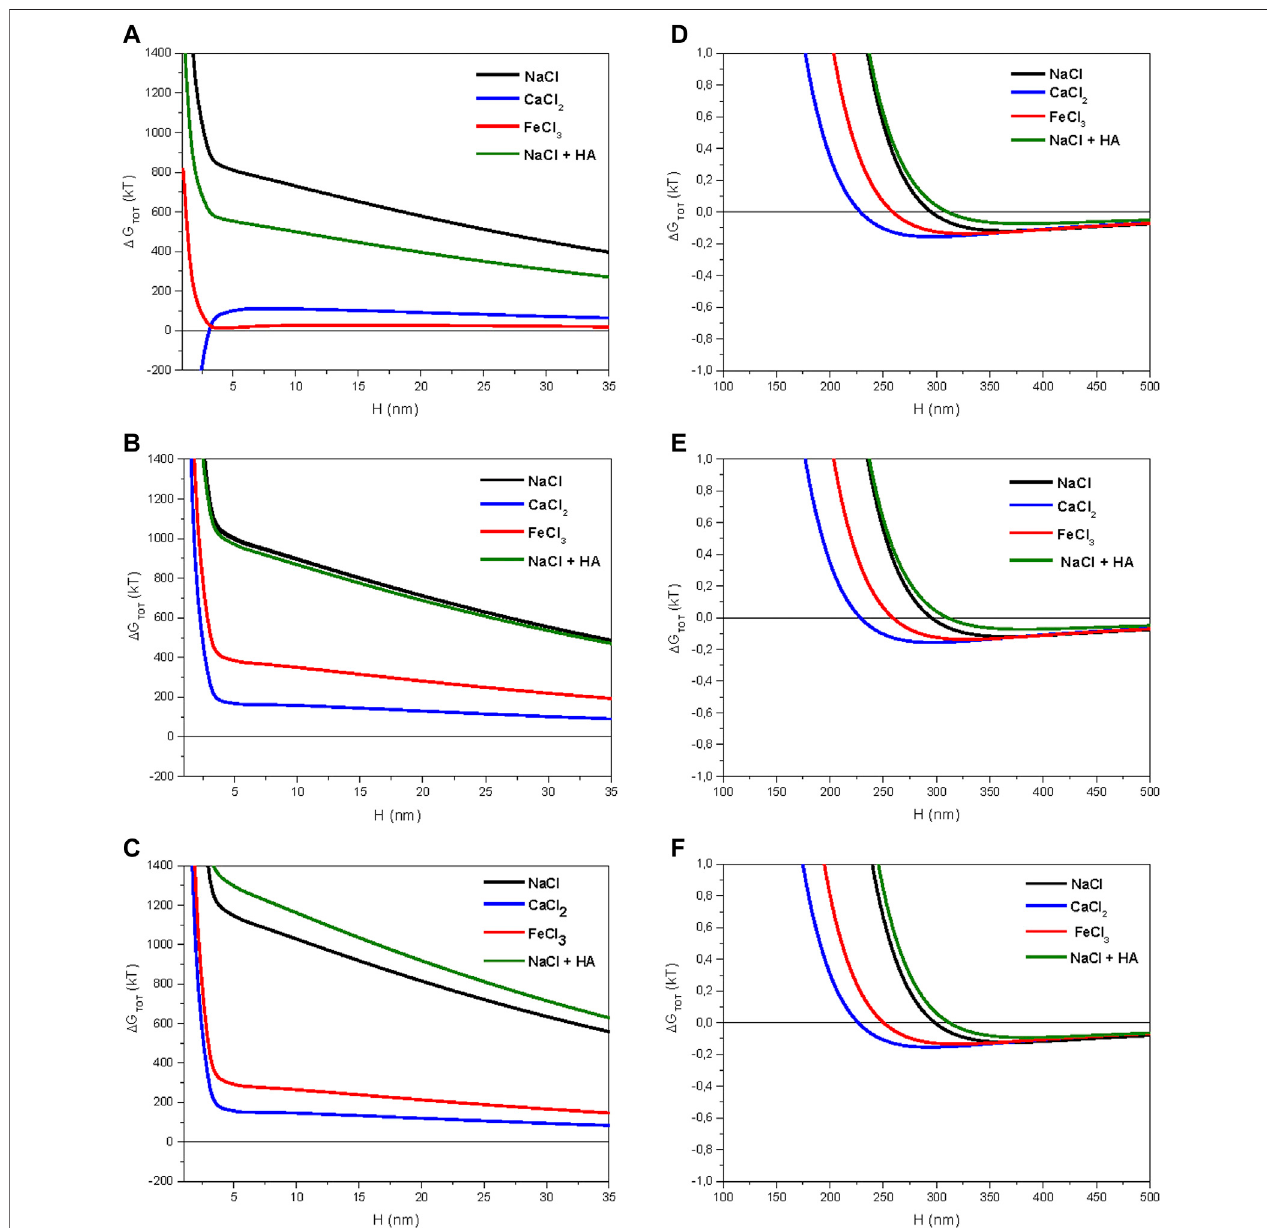
FIGURE4| Totalenergiesofinteractionbetweenparticlesaccordingtodifferentionicsolutions(10 – 3 M): (A) forestsample(pH6.47); (B) organicsample(pH6.44); (C) conventionalsample(pH6.17); (D) secondaryenergyminimumforforestsample; (E) secondaryenergyminimumfororganicsample; (F) secondaryenergyminimum for conventional